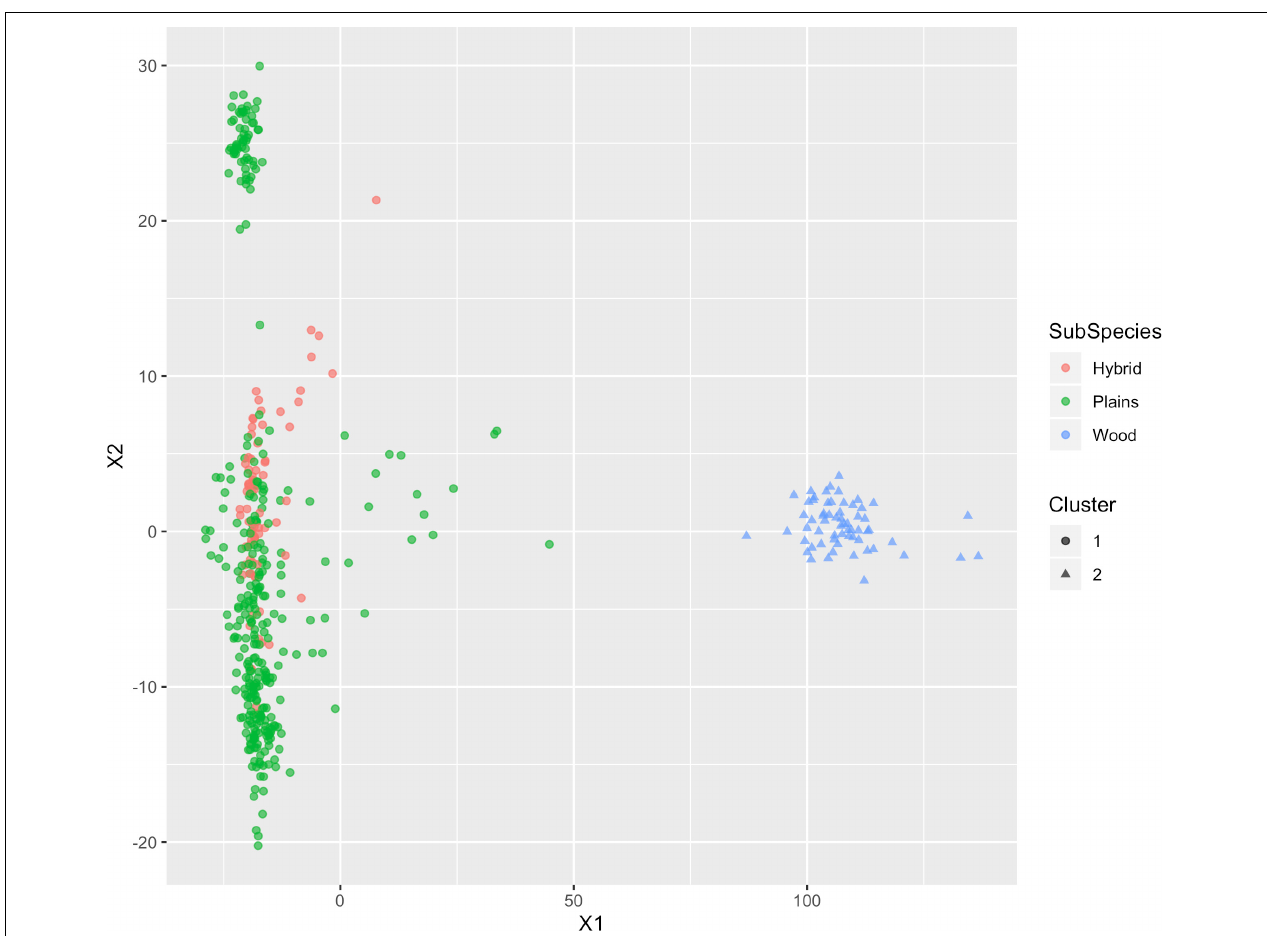
FIGURE 7 | Multi-dimensional scaling (MDS) visualization of genetic distances between plains and wood bison determined using the custom panel. Cluster inference was performed by k-means clustering.